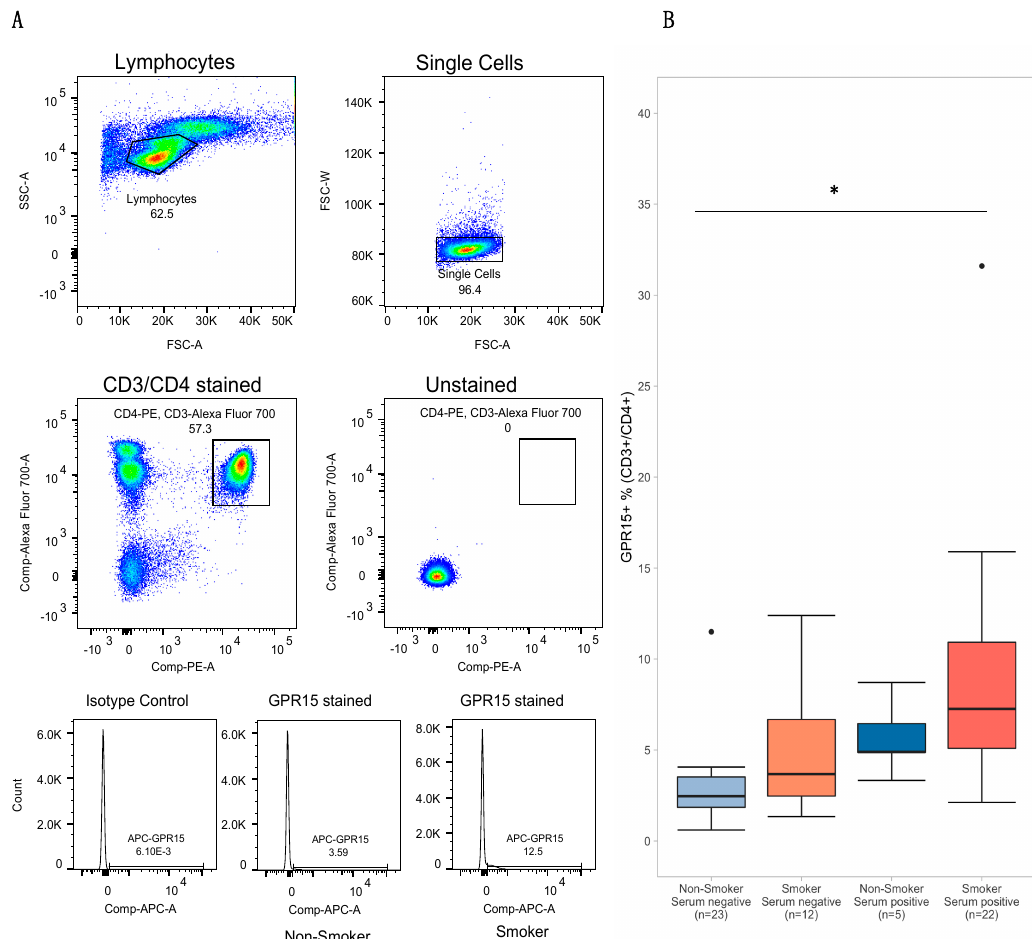
Figure 3. GPR15 + Th cell flow cytometry gating strategy and results stratified by smoking status and serum positivity. Panel ( A ) depicts the flow cytometry gating strategy used to visualize GPR15 + T h cell percent within the CD3 + CD4 + population of peripheral lymphocytes. Histograms at bottom depict GPR15 + T h cell percent data from two subjects, one a “non-smoker”, negative for both self-reported smoking and serum cotinine and tetrahydrocannabinol (THC) , and the other a “smoker”, positive for self-reported smoking and both cotinine and THC. The leftmost histogram depicts the results from the same “non-smoker” using the mouse IgG2a kappa isotype as a negative control. Panel ( B ) depicts boxplots of T h cell percent for subjects stratified by self-reported smoking status (tobacco and / or cannabis) and serum positivity (cotinine > 1 ng / mL and / or THC > 0.5 ng / mL). Significance codes: * p ≤ 0.05; ** p ≤ 0.01; *** p ≤ 0.001 (Tukey’s Honest Significant Difference).